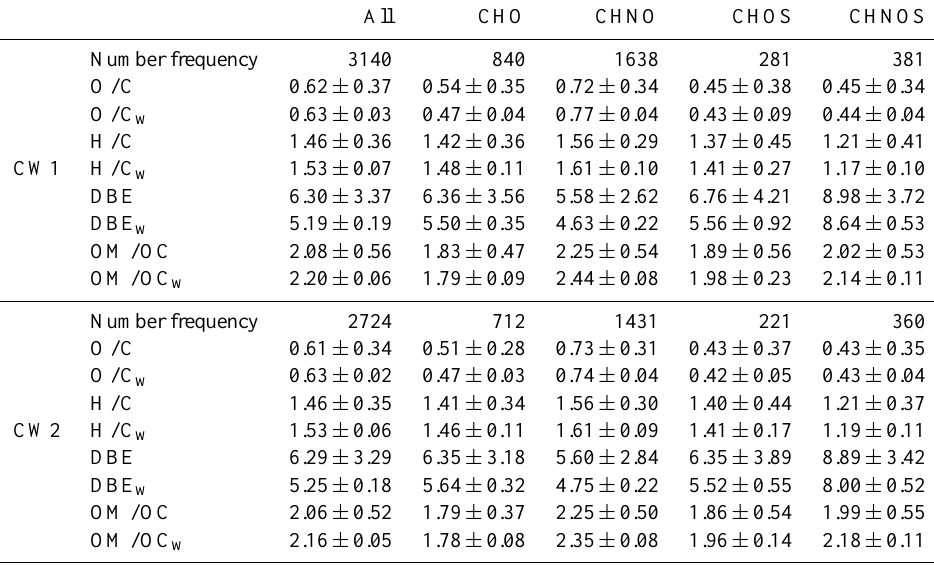
Table 1. Cloud water composition characteristics by elemental groups.